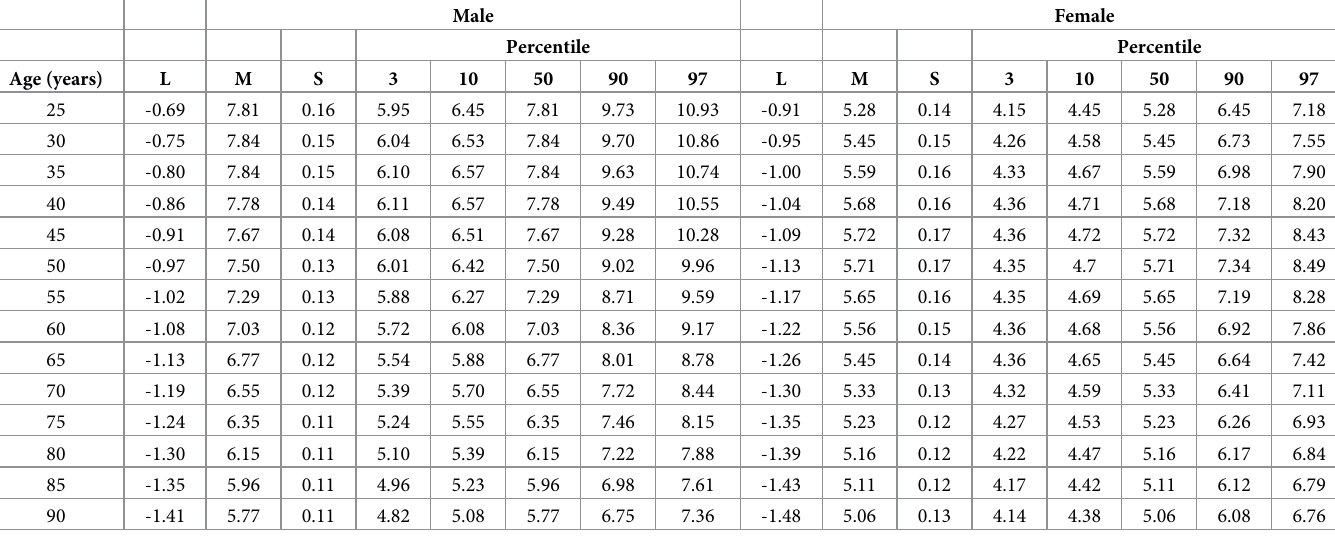
Table 4. Sex-specific percentile values for appendicular lean mass index (aLMI) in individuals aged 21–90 years. Male Female Percentile Percentile Age